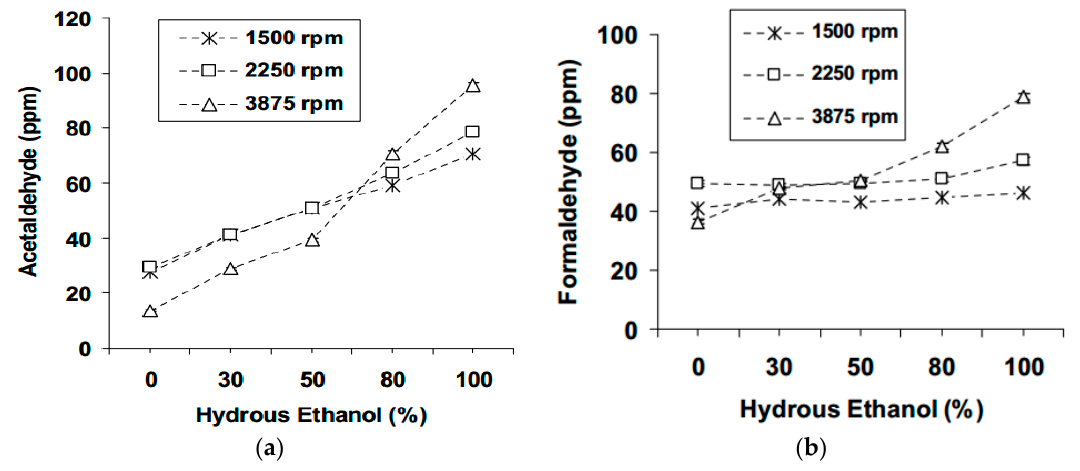
Figure 9. Effect of increased hydrous ethanol content (water content from 6.5 up to 7.5% (wt/wt)) in gasoline on ( a ) Acetaldehyde ( b ) Formaldehyde emissions. Reprinted with permission from Ref. [42]. Copyright (2011) SAE International.